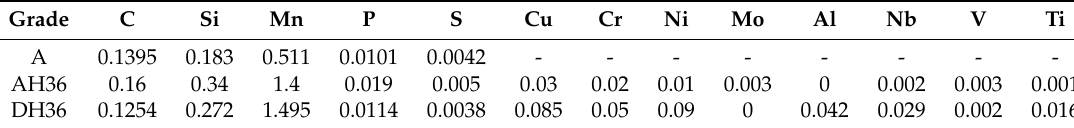
Table 1. Chemical composition of the tested steels (wt.%).